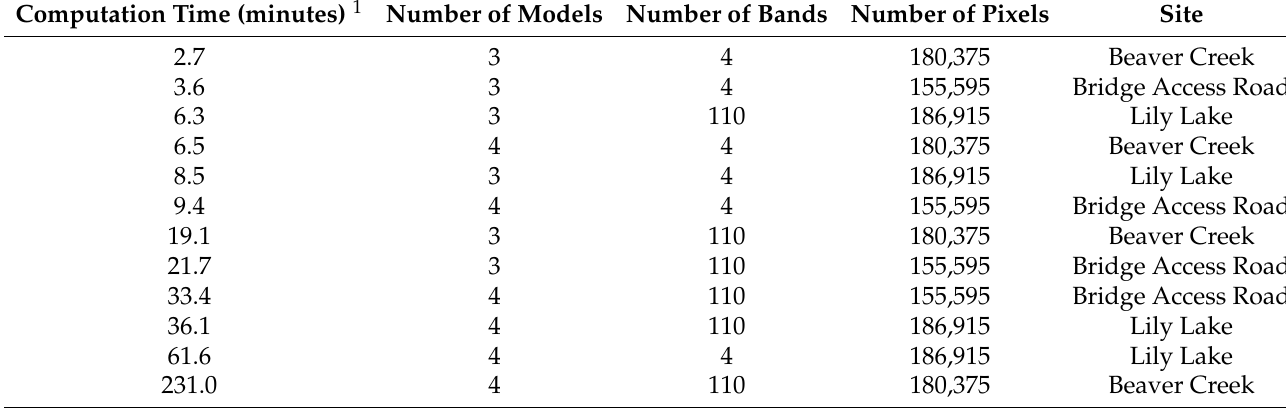
Table 8. Computational costs, shown from low to high number of minutes, of unmixing the larger, unsampled imagery swaths, for model complexity for 3 and 4